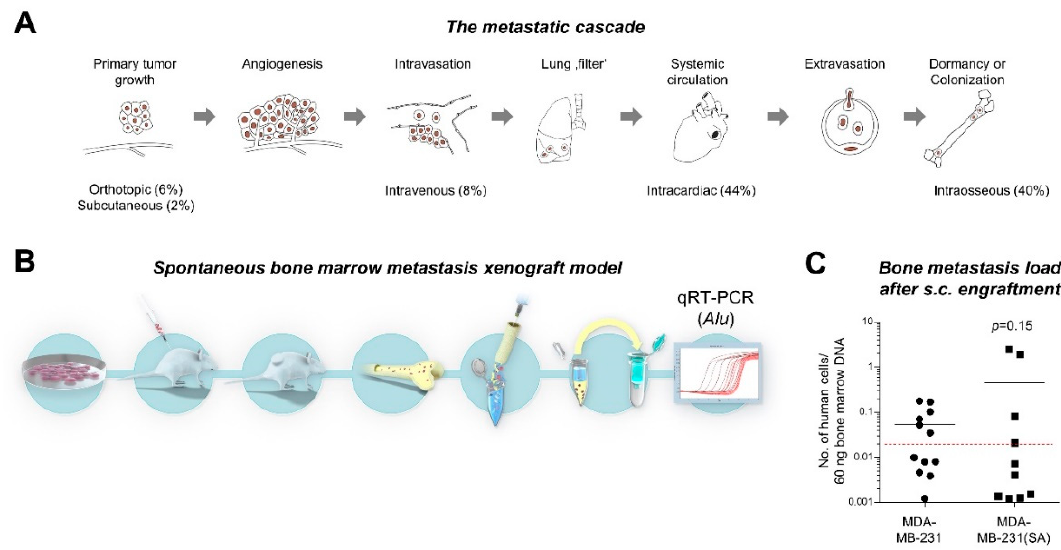
Figure 1. Concept of the study and development of spontaneous bone marrow (BM) metastasis xenograft models. ( A ) About 92% of currently used models circumvent early steps of the metastatic cascade by using intravenous, intracardiac, or intraosseous tumor cell injection (illustration modified from Lange et al. [13]). ( B ). After subcutaneous (s.c.) engraftment of human tumor cells and growth of primary xenograft tumors, the spontaneous metastatic cell load can be determined in the BM by means of the human DNA content ( Alu -PCR). ( C ) The MDA-MB-231(SA) cell line, a “bone-seeking” subline of MDA-MB-231 established by others using intracardiac injection experiments [11,12], showed no increased BM metastasis formation in our spontaneous metastasis xenograft model compared to the parental MDA-MB-231 cell line. The black lines represent the median number of human cells per 60 ng bone marrow DNA, the dashed red line indicates the detection limit of human cells in the respective Alu -PCR.